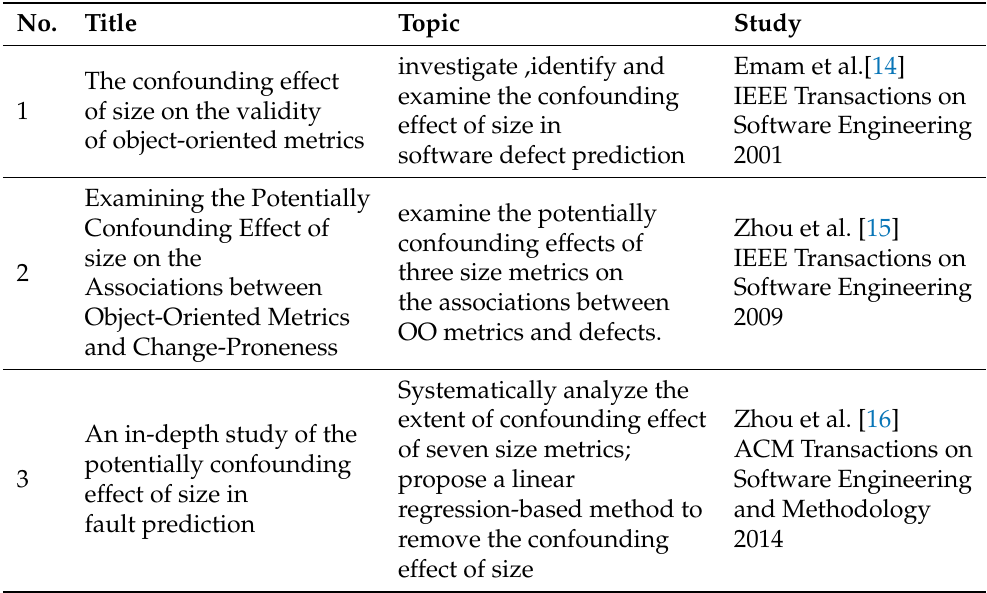
Table 1. The literature on the confounding effect in software defect